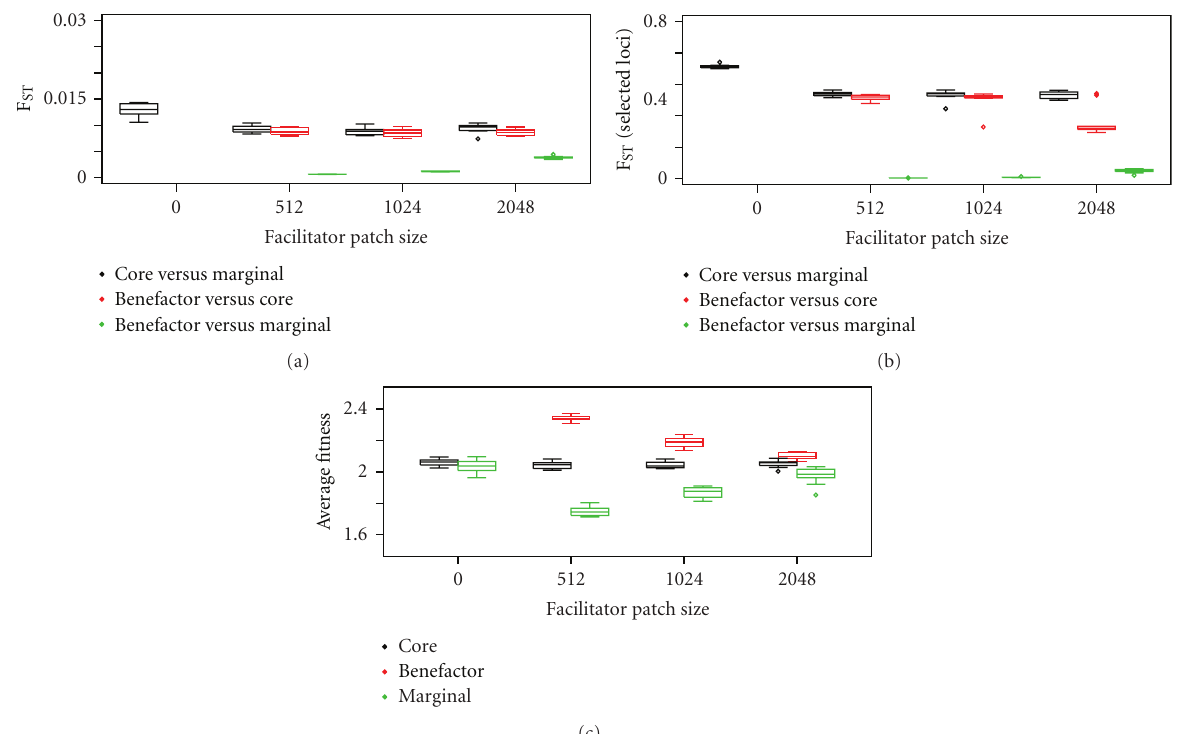
Figure 2: Facilitation acting as a cohesive force and reducing the chance of ecological speciation. (a) represents the population divergence at neutral loci as a function of the size of patch. (b) represents the same population divergence at selected loci. (c) represents the average fitness in each environment as a function of the patch size (Box 1) . Consistent with our hypothesis, in the absence of benefactors (i.e., no facilitation, patch size of 0), populations were locally adapted and gene flow was reduced between the core and the marginal habitat (higher F ST on both neutral and selected loci). In the presence of benefactors, adaptation to the marginal environment was reduced by the increased gene flow from the core population and especially from populations occupying the mild patches created by the benefactors. Individuals occupying these benefactor patches have an increased fitness because of the low population density in the neighboring maladapted marginal environment that inflates the logistic growth part of the fitness function. As the size of the patches increased, migration and gene flow decreased between the patches created by the benefactors and marginal environment (increased F ST on both neutral and selected loci). Because of this reduction in gene flow, the average fitness in the marginal environment increased, and consequently the fitness advantage in the benefactor patches decreased. Additionally, the F ST for selected loci between the core and the benefactors, even though still high, is reduced at large patch size. This is because each patch has a subpopulation that can achieve the same phenotype using di ff erent genotypic combinations. Thus, as the patch size increased the number of patches decreased, the number of subpopulation decreased, the genotypic variance within an environment decreased, and so did the F ST